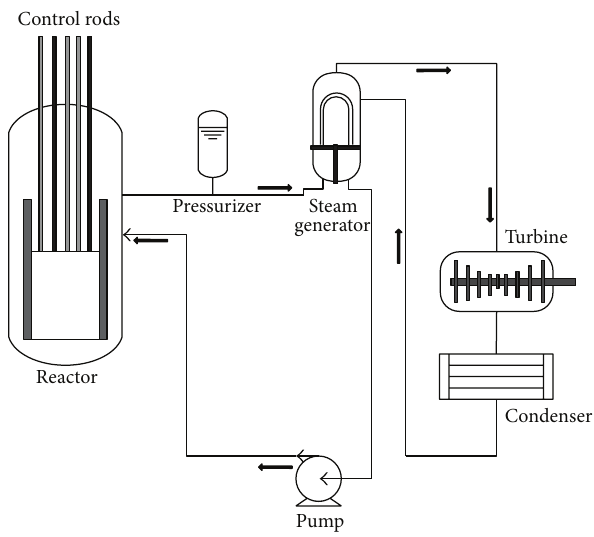
Figure 5: Sketch of SCWR with two